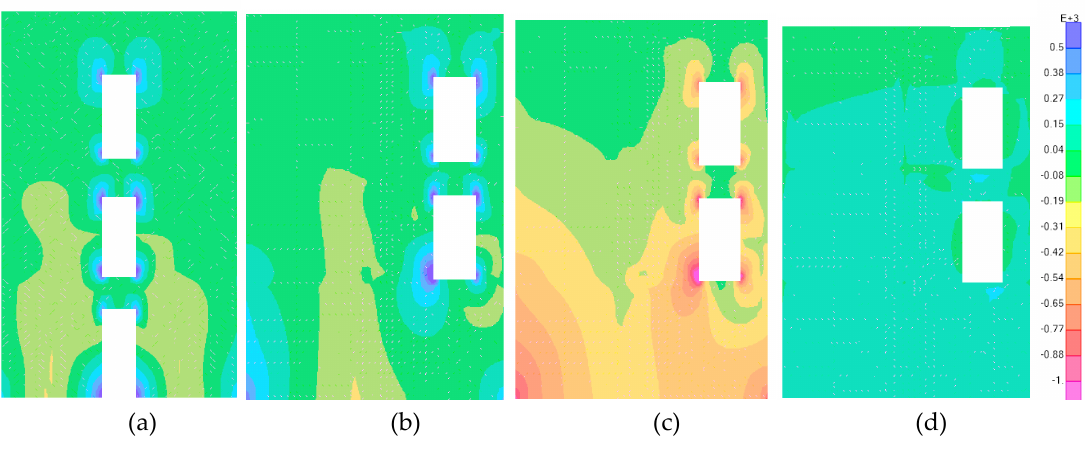
Figure 14. Force per meter under load combination dead + live + response spectrum ‐ x ( a ) tensile force at section cut ‐ 1, ( b ) tensile force at section cut ‐ 2, ( c ) compressive force at section cut ‐ 2, and ( d ) shearing force at section cut ‐ 2. (See Figure 10 for section cuts).